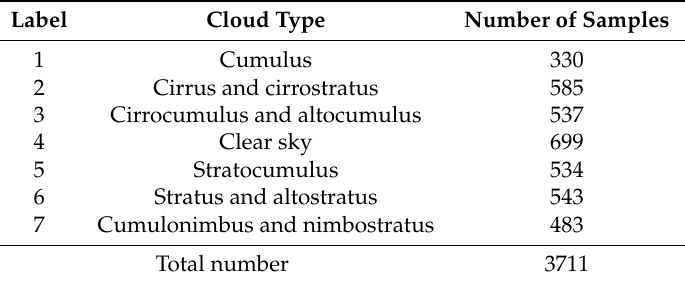
Table 2. The sample number of each cloud class on the MGC dataset.